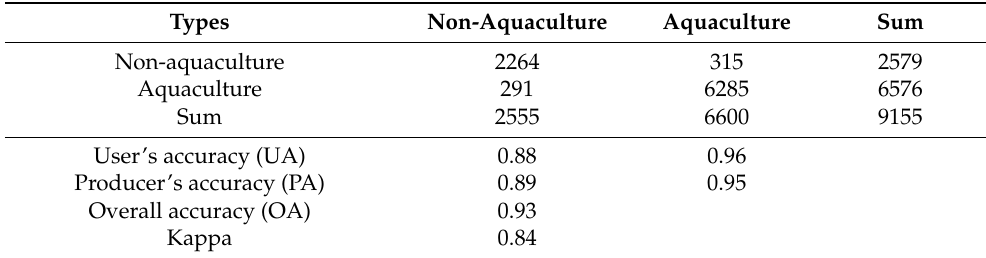
Table 1. Confusion matrix of extraction results and manual interpretation results. Types